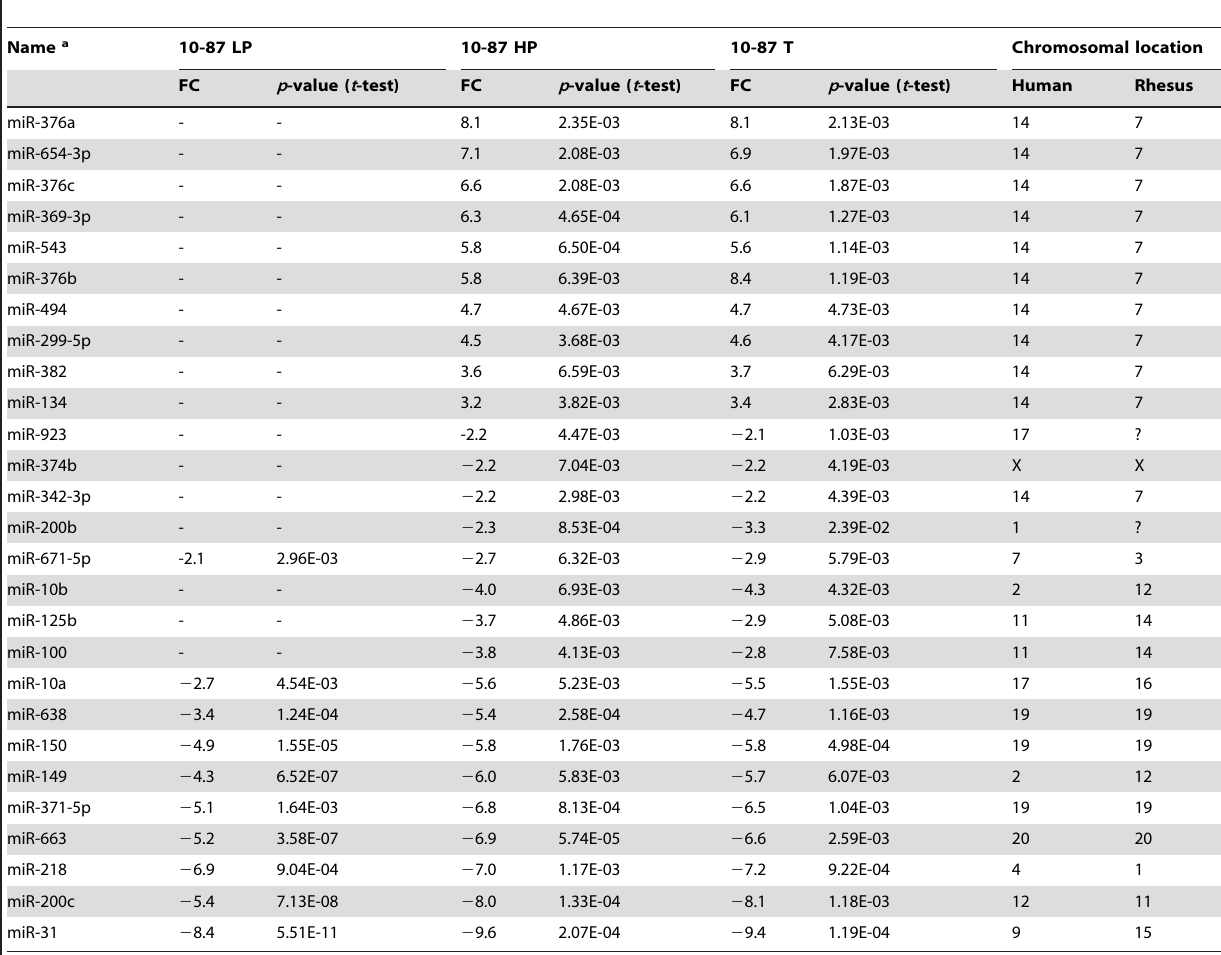
Table 2. Differentially expressed mature miRNAs in low-passage and high-passage VERO cells in comparison with pAGMK cells.